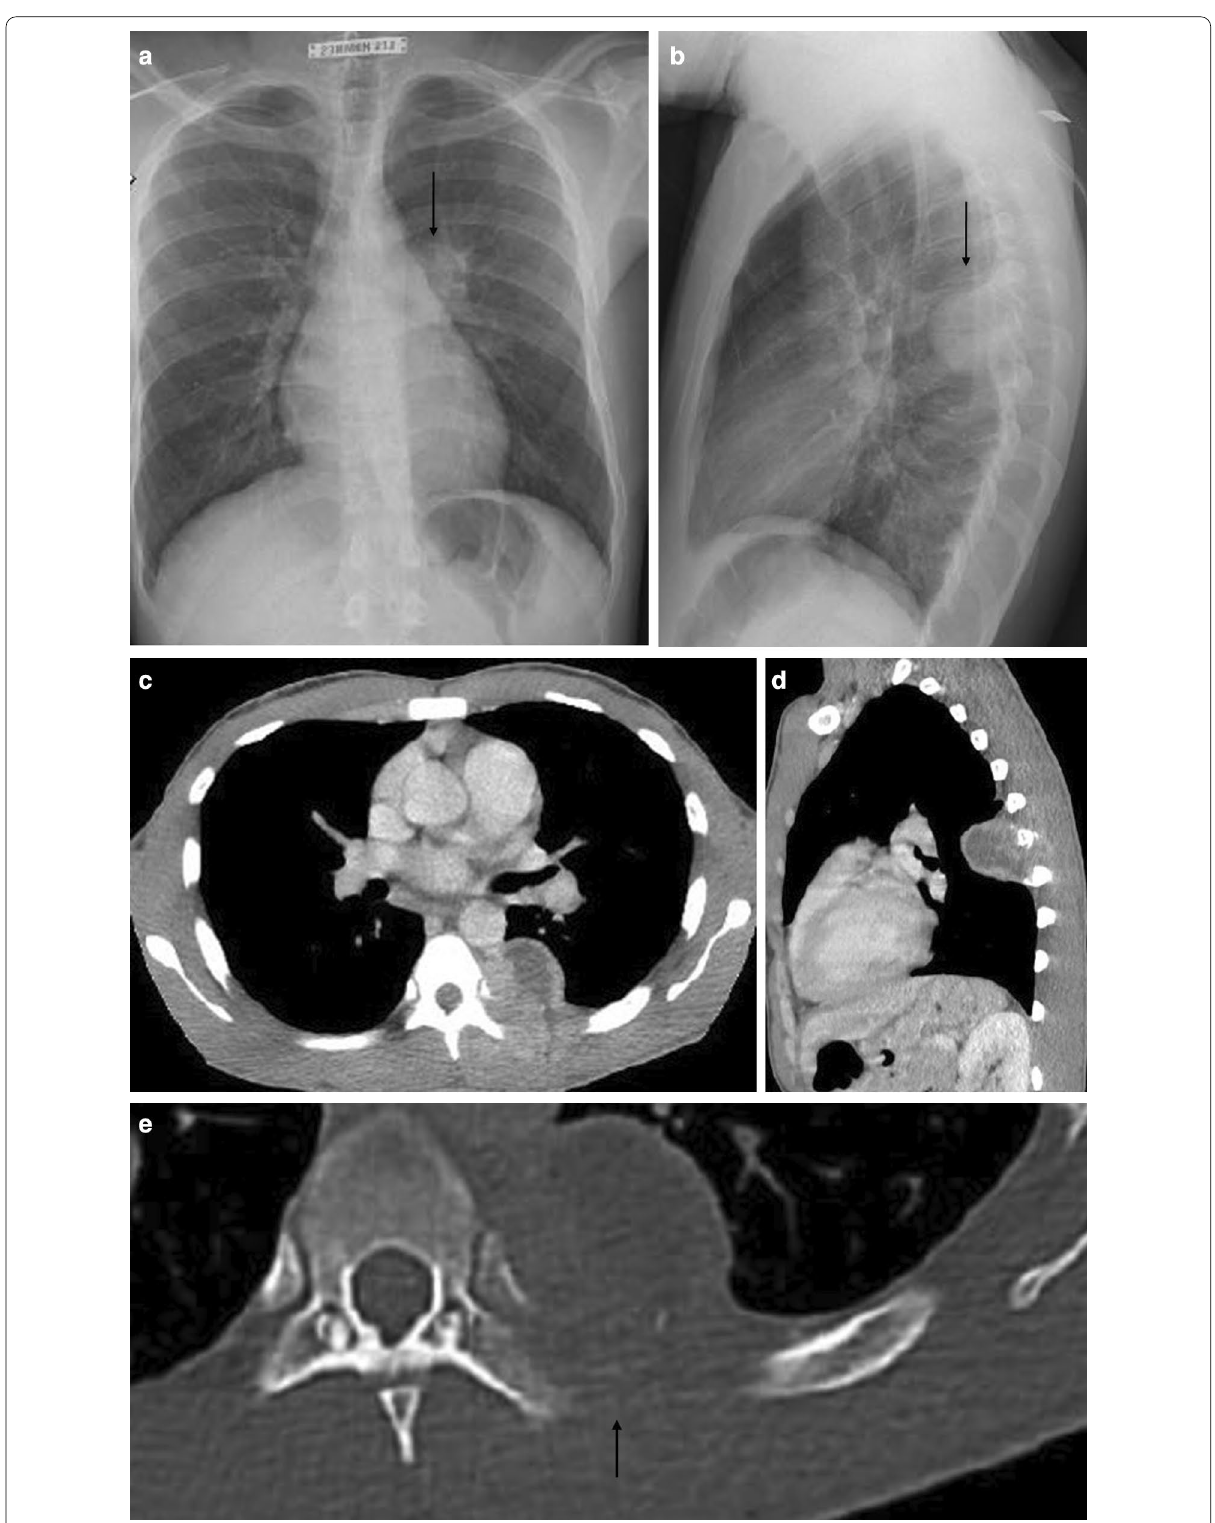
Fig. 17 (See legend on previous